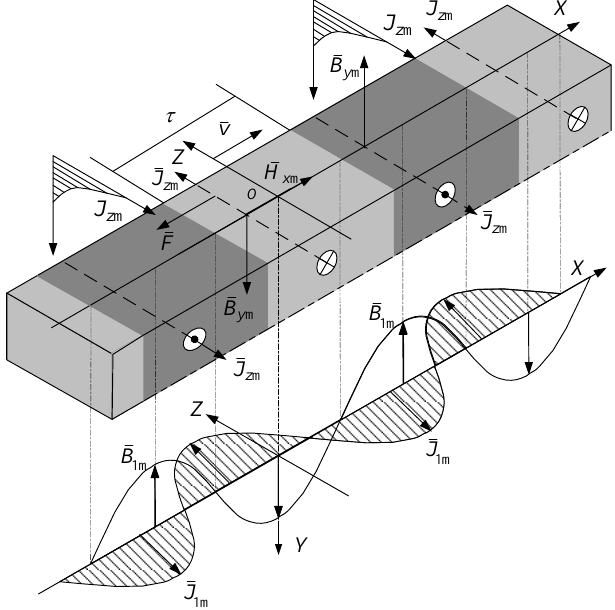
Figure 10. Unfolding diagram of the stator for the mathematical model of eddy current. X , Y , and Z are circumferential, radial, and axial directions respectively; J z m is the amplitude of eddy current in the axial direction; τ is the pole pitch; v is the speed; B y m is the amplitude of flux density in the radial direction; B 1m is the amplitude of the fundamental wave of flux density; and J 1m is the amplitude of the fundamental wave of eddy current density.